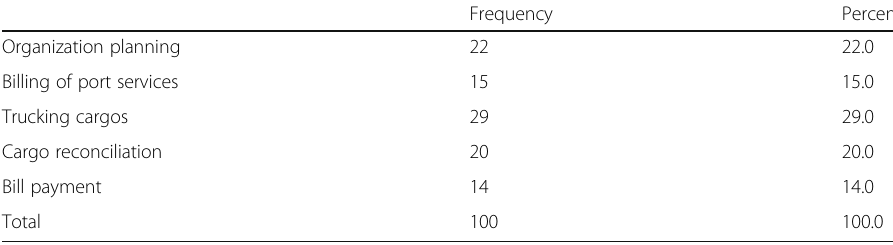
Table 5 Reasons for Information Systems Usage